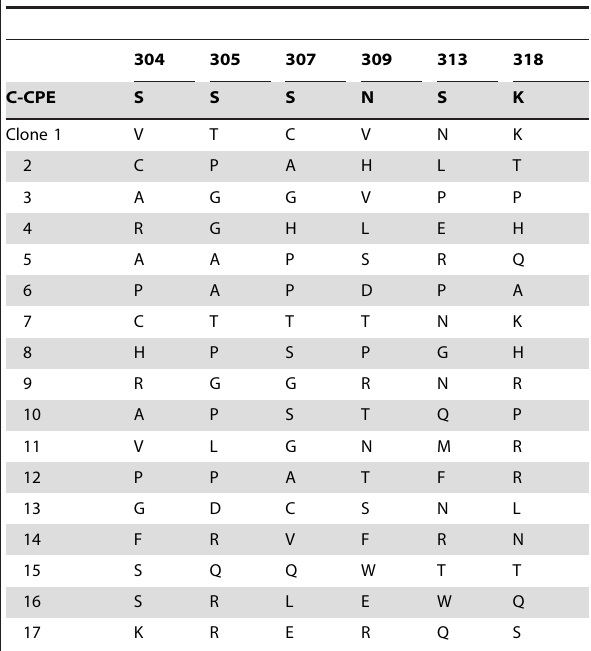
Table 1. C-CPE phage